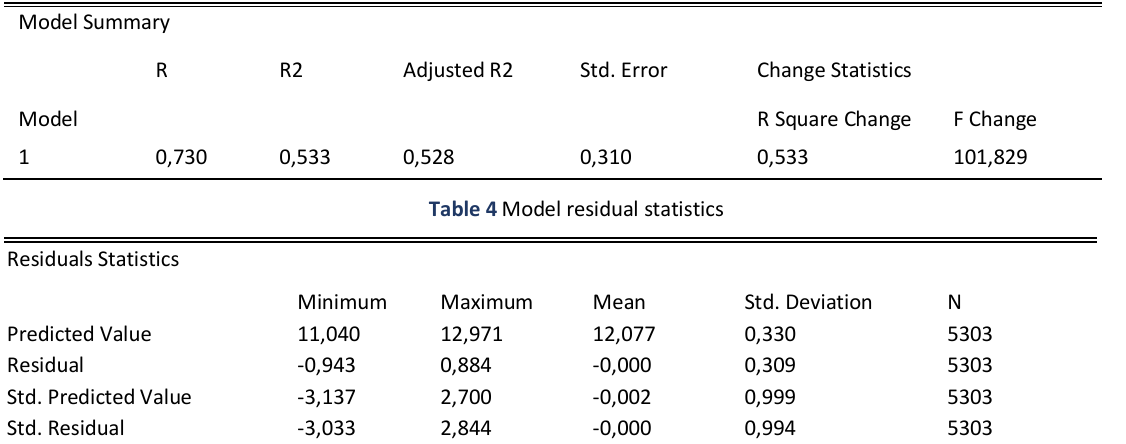
Table 3 Model summary